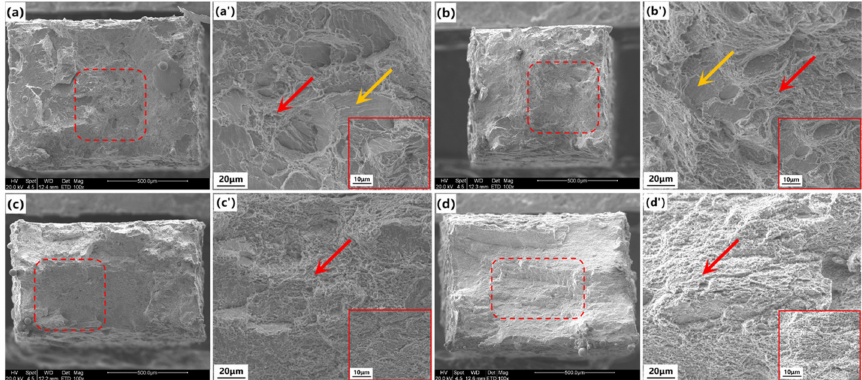
Figure 12. Fracture surfaces of tensile samples at ( a – d ) macroscopic and ( a (cid:48) – d (cid:48) ) microscopic levels with different strains: ( a ) 20%, ( b ) 40%, ( c ) 60%, ( d )